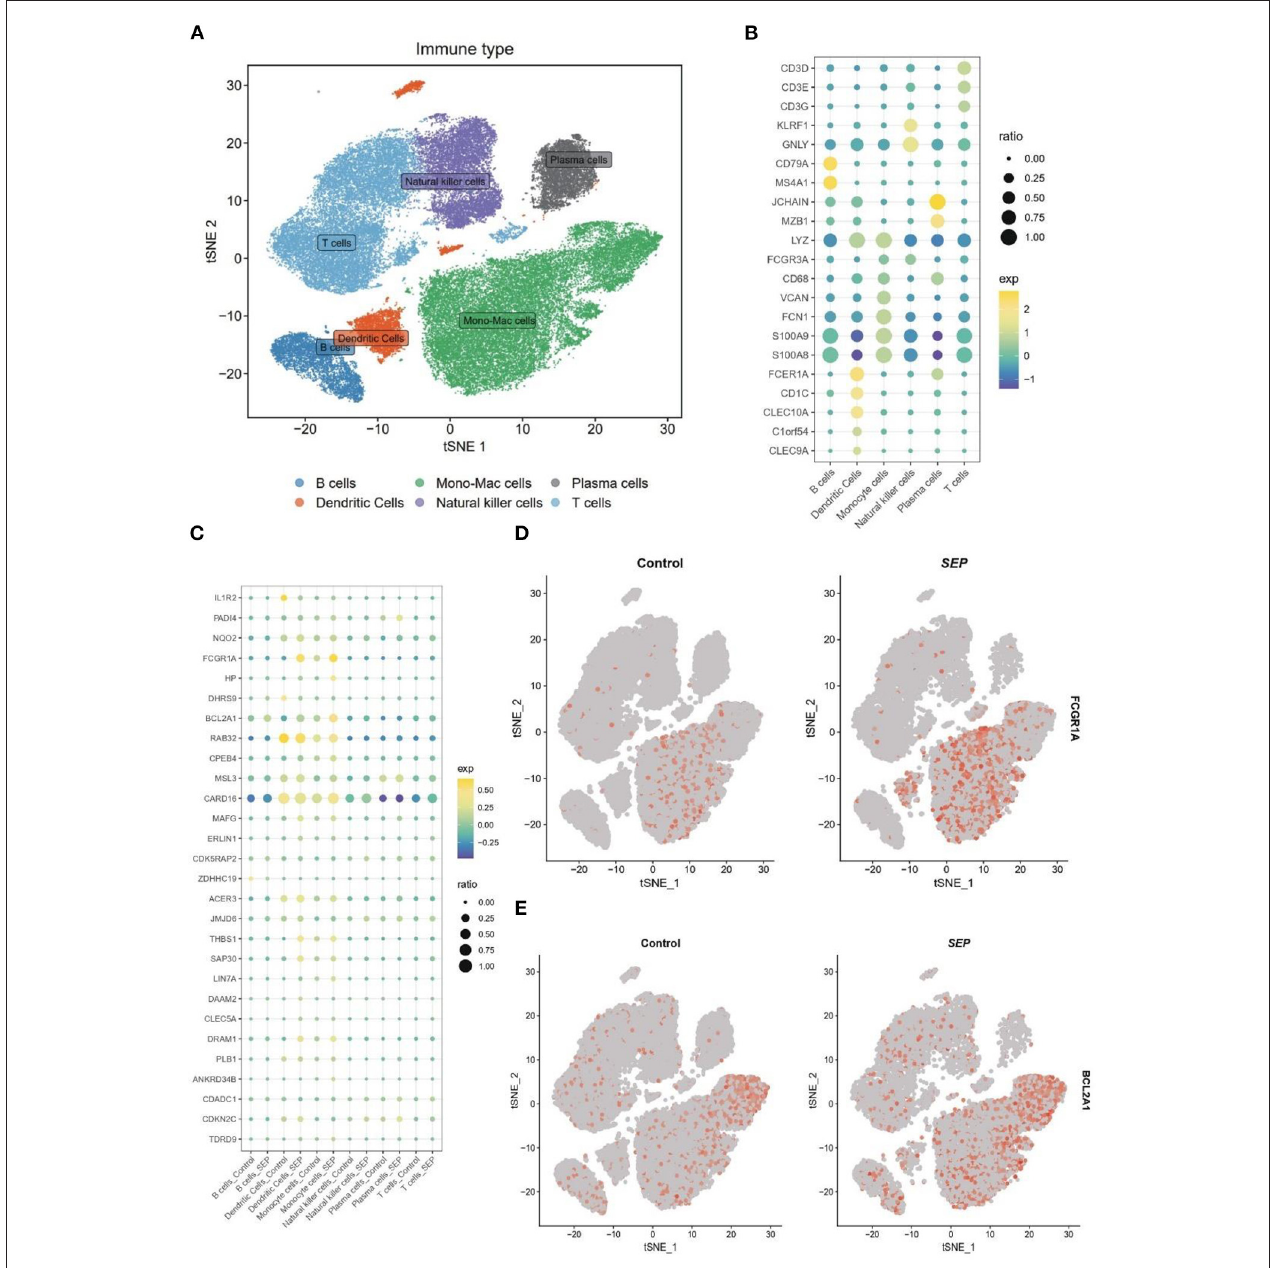
FIGURE 5 | Differential expression of target genes on a single-cell level. (A) t-SNE plot of 60,543 cells from SCP548 datasets. Distinct cell types are shown in different colors. (B) Dot plot showing the respective marker genes of different cell types. (C) A dot plot showing that the expression levels of 17 genes differ between the sepsis and healthy samples. (D,E) Expression of FCGR1A and BCL2A1 shown using a t-SNE plot. t-SNE, t-distributed stochastic neighbor